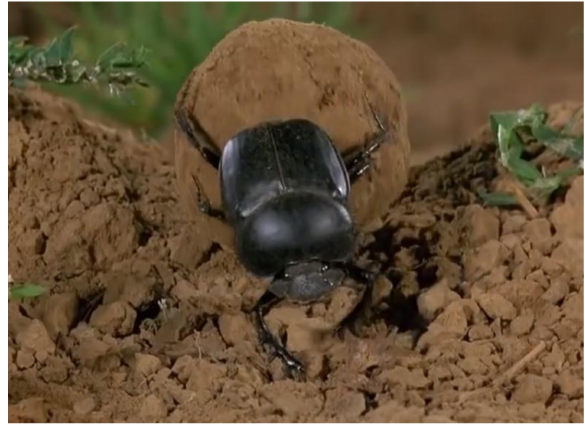
Figure 1. Dung rolling of the dung beetle